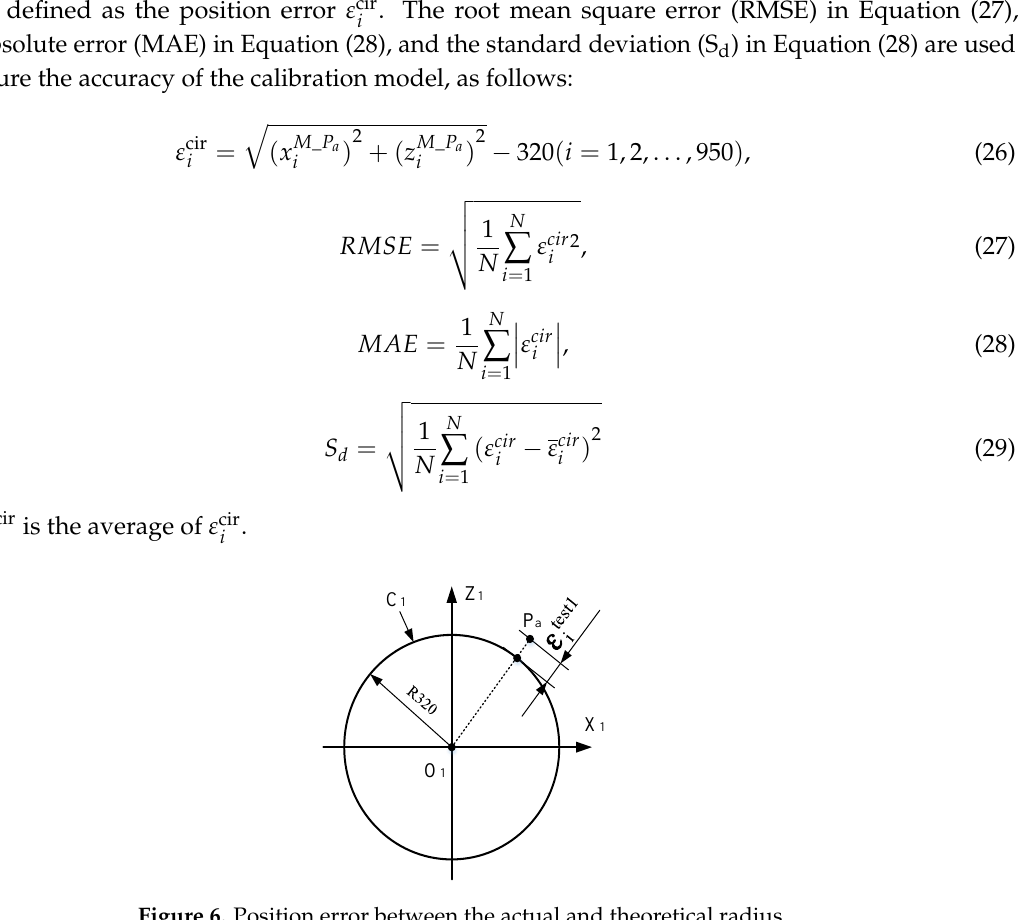
Figure 6. Position error between the actual and theoretical radius.